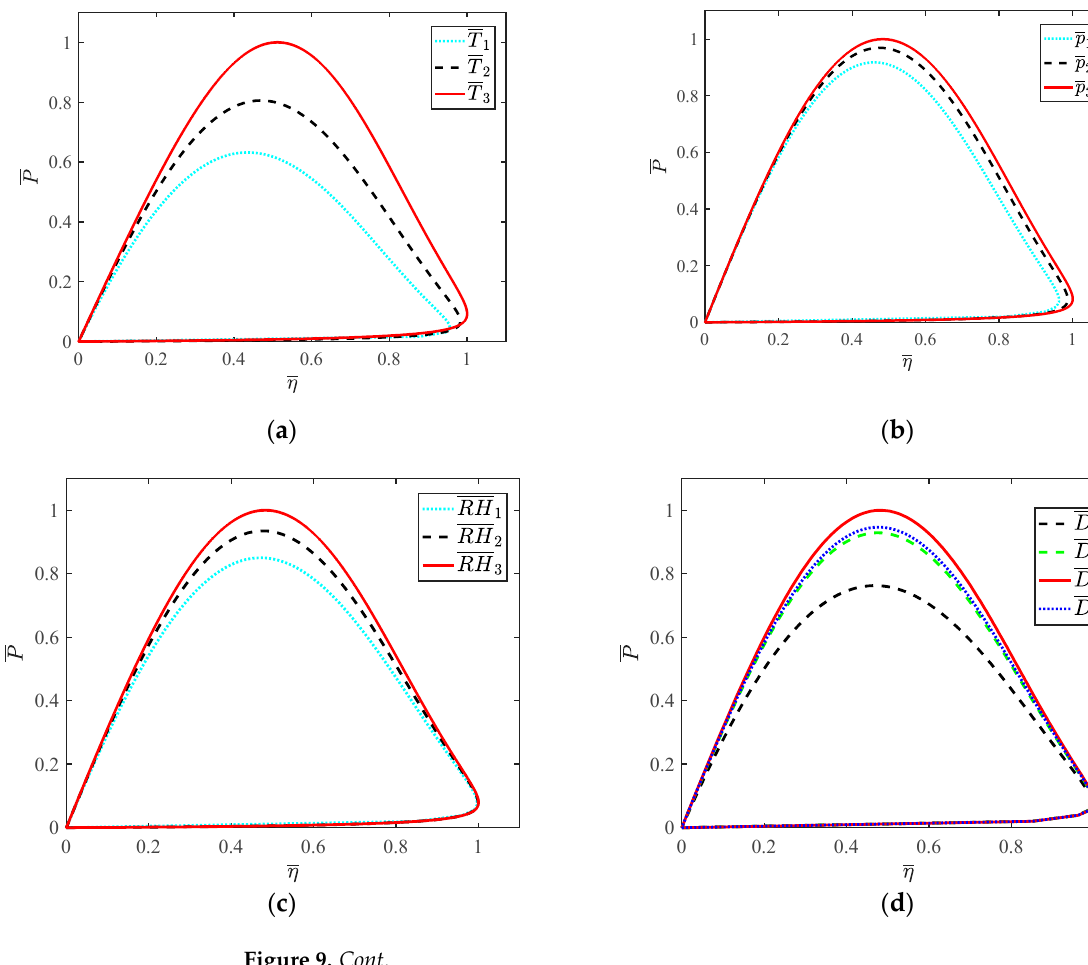
( e ) Figure 9. The relationship between power density and thermal efficiency: ( a ) 𝑇(cid:3364) ; ( b ) 𝑝̅ ; ( c ) 𝑅𝐻(cid:3364)(cid:3364)(cid:3364)(cid:3364) ; ( d ) 𝐷𝐿(cid:3364)(cid:3364)(cid:3364)(cid:3364) ; ( e ) 𝑡̅ (cid:2923)(cid:2915)(cid:2923) . 4. Conclusions In order to evaluate the thermodynamic performance of the HT-PEMFC, finite time thermodynamics was used to establish the HT-PEMFC model which considers three kinds of overpotential and leakage current density. The expressions of power density, thermal efficiency, exergy efficiency, exergetic performance coefficient ( 𝐸𝑃𝐶 ), entropy production rate and ecological coefficient of performance ( 𝐸𝐶𝑂𝑃 ) were deduced. By analyzing the influence of main parameters on HT-PEMFC, it was found that operating temperature, doping level and membrane thickness have a great influence on HT-PEMFC. With